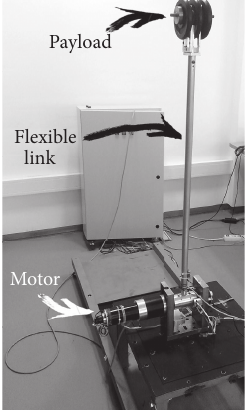
Figure 2: Flexible single-link robot platform.